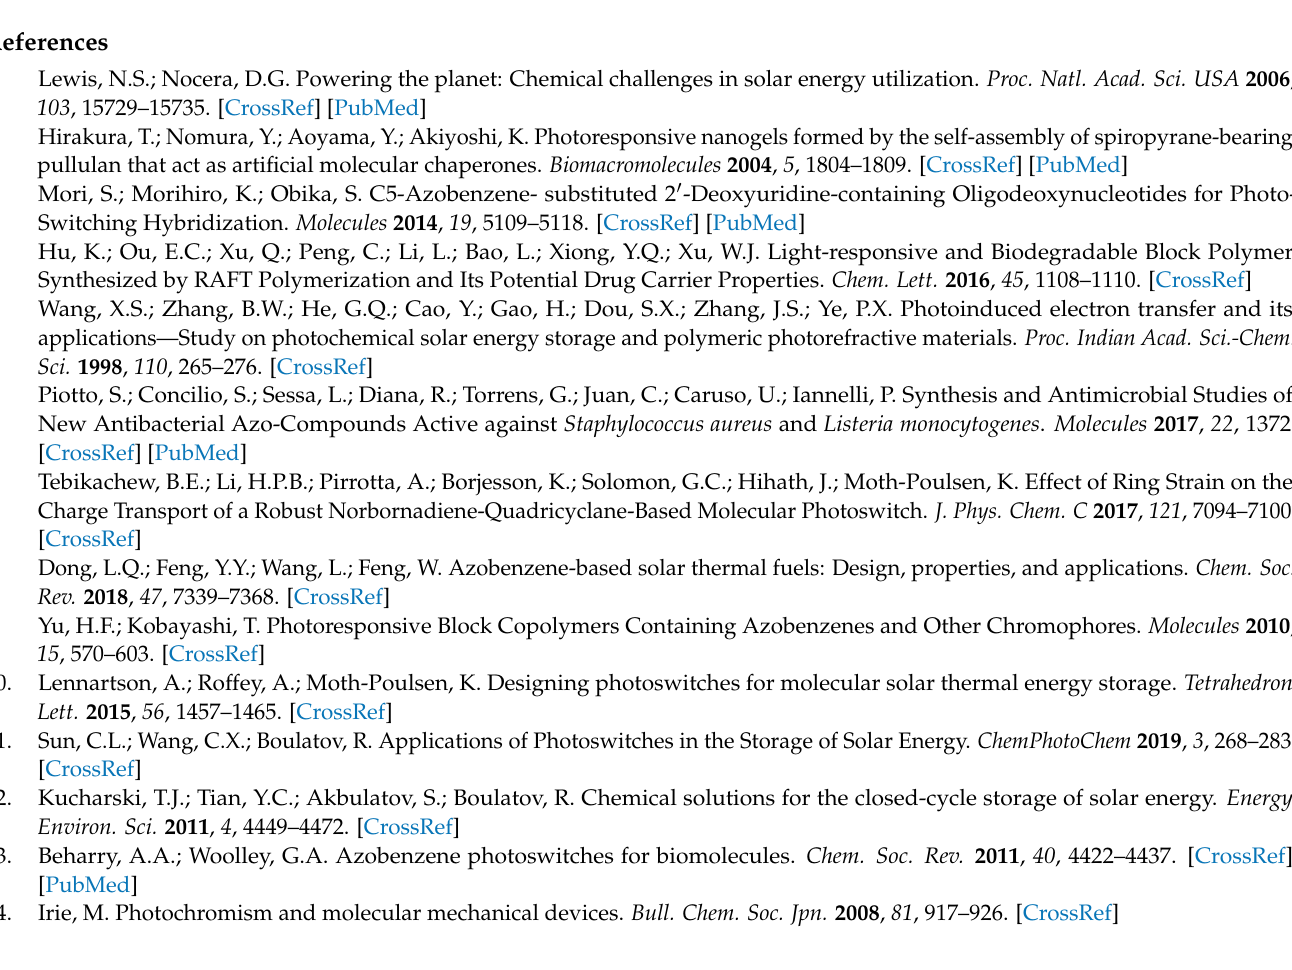
Figure S18: Photographs of the four compounds in two isomeric states; Figures S19–S21: UV–vis absorption spectra of four azobenzene chromophores; Figure S22: First-order kinetic constants for three processes; Figure S23: Charging and discharging cycle diagrams of four azobenzene chromophores; Table S1: Parameters related to the kinetics of partial isomerization.; Videos S1–S4: IR thermal video for low-temperature ( − 1.0 ◦ C) heat output of four